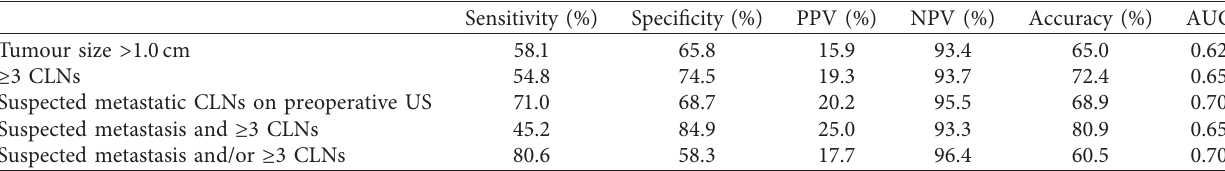
Table 3: Diagnostic efficiency of features for large-volume